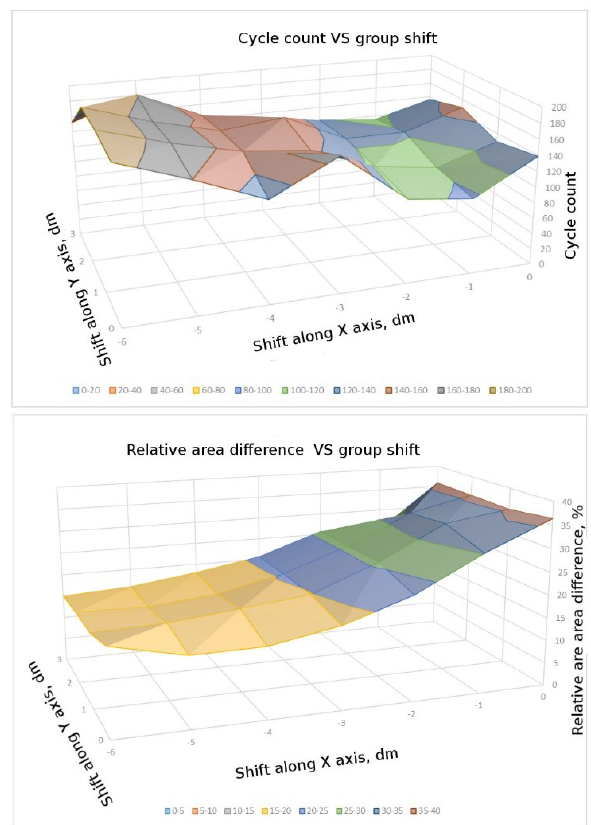
Figure 12: Robotic group start position shift study results.